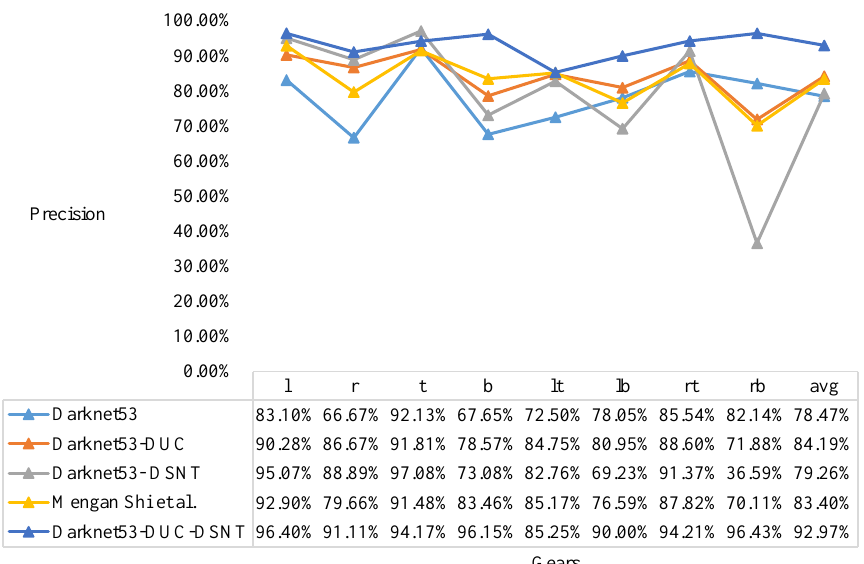
Figure 13. Precision results of knob gear classification. Comparison of Darknet53, Darknet53-DUC, Darknet53-DSNT, Mengan Shi [21], and our model.